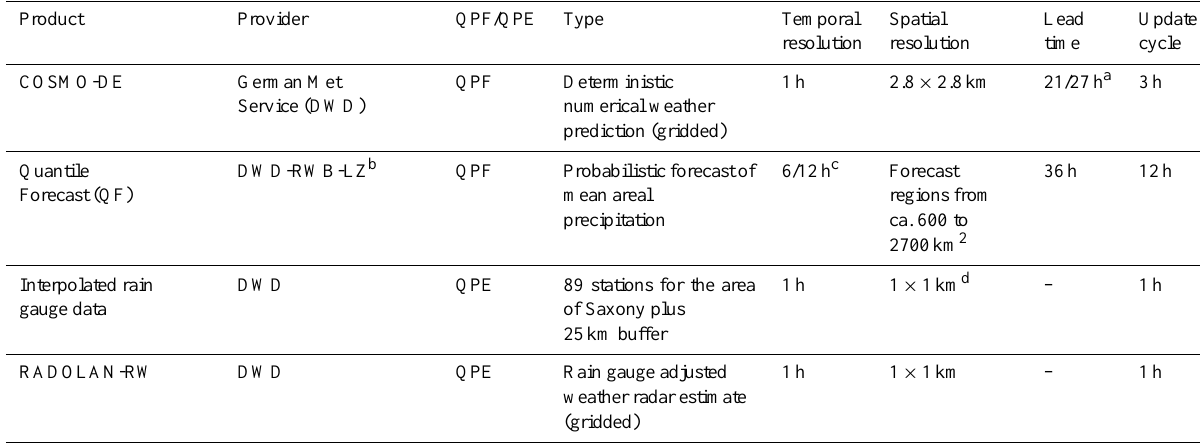
Table 1. Overview of the considered QPF and QPE products.